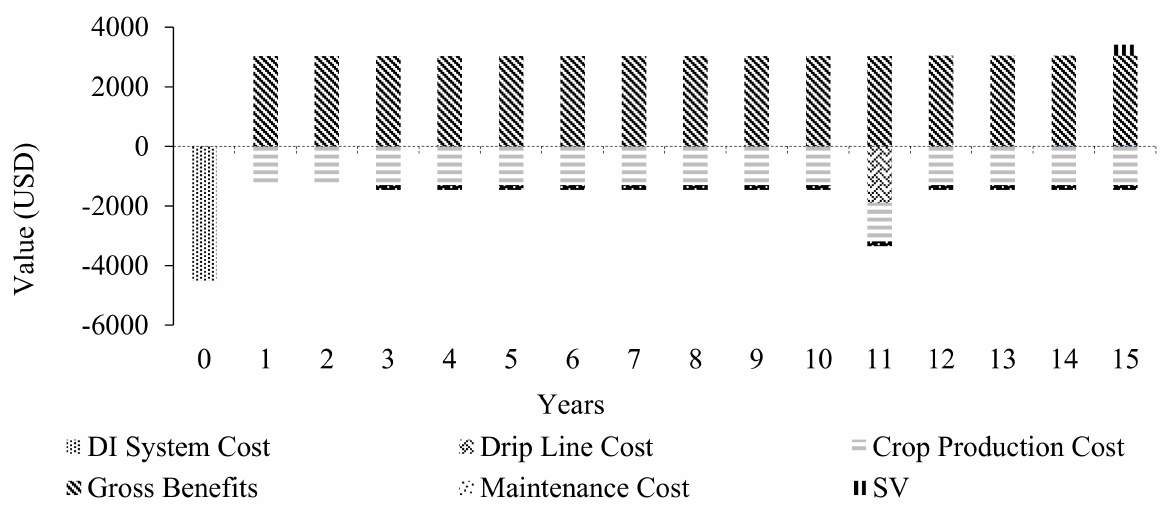
Figure 6. Cashflow diagram for electric power drip irrigation system.